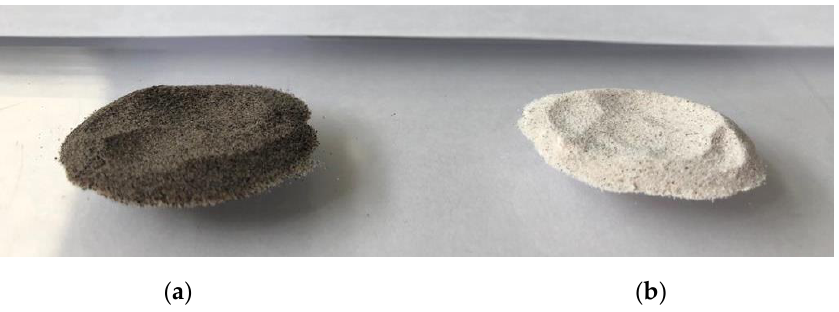
Figure A4 . Deconvolution of the TPR curve, with 950 °C as maximum temperature for a fresh 4% Fe/10% CaO- γ-Al 2 O 3 catalyst sample:( a ) adjustment curve with R 2 =0.9996, ( b ) composition curves, ( c ) regression residues, ( d ) probability distribution of the adjustment curve selected.